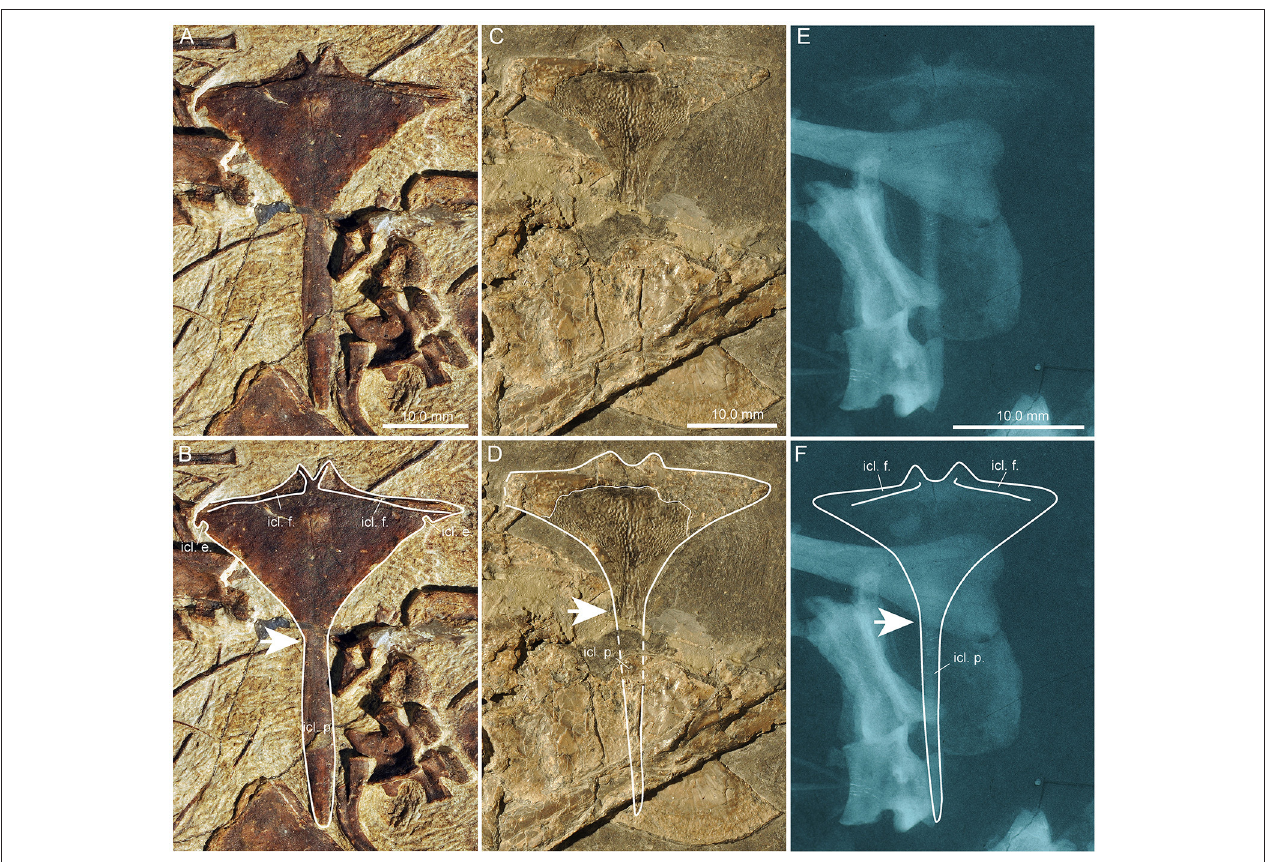
FIGURE 7 | Comparison of the interclavicles of several specimens of Macrocnemus . Photographs (A–D) and X-ray images (E,F) of interclavicles with interpretative drawings superimposed (B,D,F) . (A,B) PIMUZ T 1559; (C,D) PIMUZ T 4355; (E,F) PIMUZ T 2475. The white arrows indicate transition from the anterior wing-like processes to the posterior process. Note the presence of small but clearly delineated circular emarginations present only at the posterior margins of the wing-like lateral processes of PIMUZ T